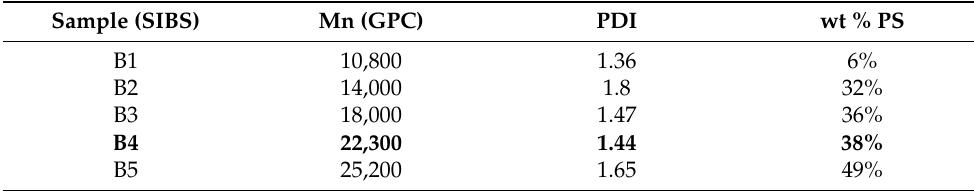
Table 1. Synthesized SIBS triblock copolymers with various molecular weights (Mn), polydispersities (PDI), and the calculated wt % of the PS